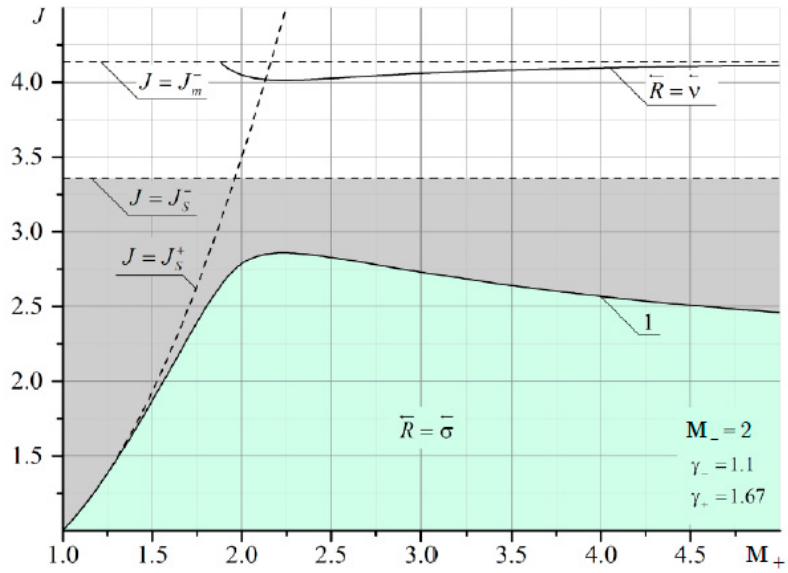
Figure A4. Domains of existence of reflected discontinuities for refraction from a gas consisting of combustion products into a monatomic gas. The Mach number of the flow from which the shock comes is M – = 2. The domains of existence of reflected discontinuities for refraction from a gas consist- ing of combustion products into a monatomic gas at the Mach number of the flow M – = 3 are shown in Figure A5.